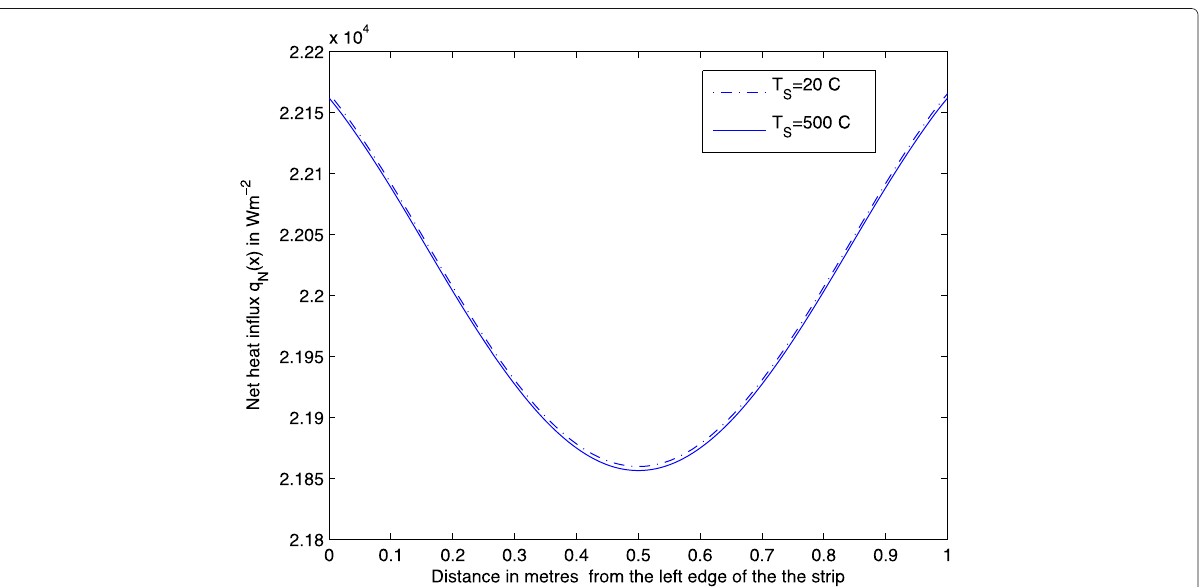
Fig. 12 The comparison of the net heat influx of the strip for T S = 500 ◦ C and T S = 20 ◦ C